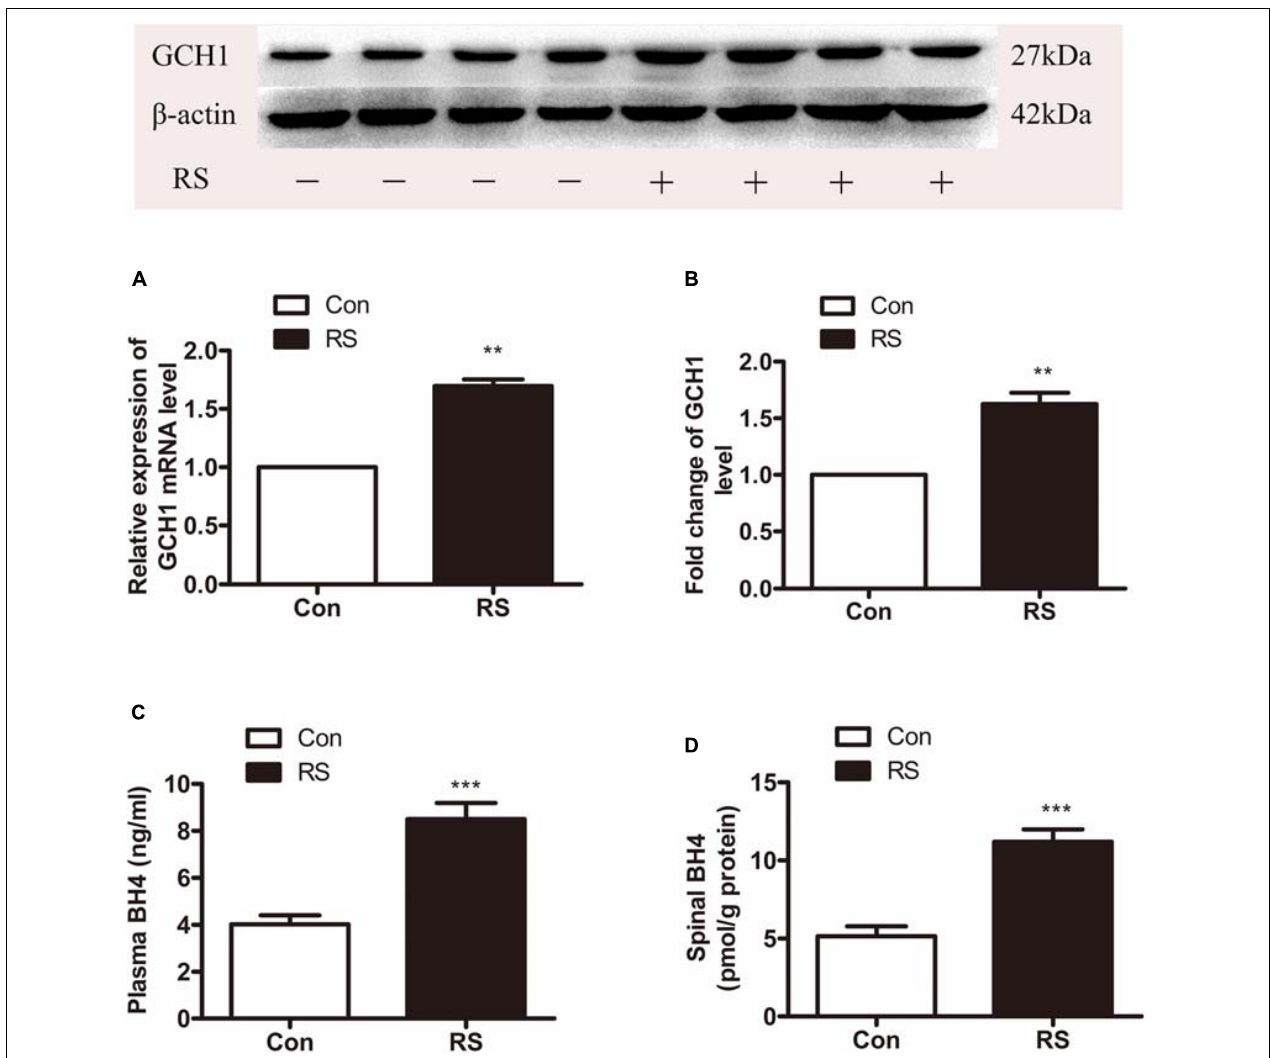
FIGURE 2 | The expression of spinal GCH1 and the production of plasma and spinal BH4 in the rats with or without chronic RS. (A,B) The expression of spinal GCH1 mRNA ( P = 0.001) and spinal GCH1 protein ( P = 0.001) in the RS rats and control rats. (C) The concentration of plasma BH4 ( P < 0.001) and spinal